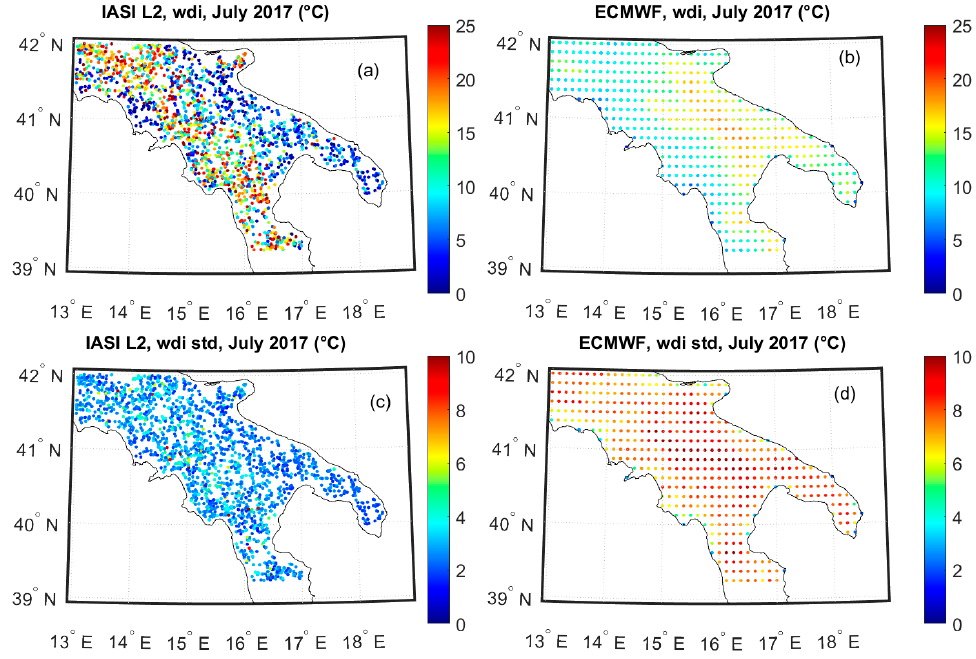
Figure 3. July 2017. IASI L2 products for wdi (panel ( a )) and its standard deviation (panel ( c )) over the target area. The figure also shows the ECMWF background field (both mean (panel ( b ) and standard deviation ( d )) at its native spatial resolution of 0.125° × 0.125°.